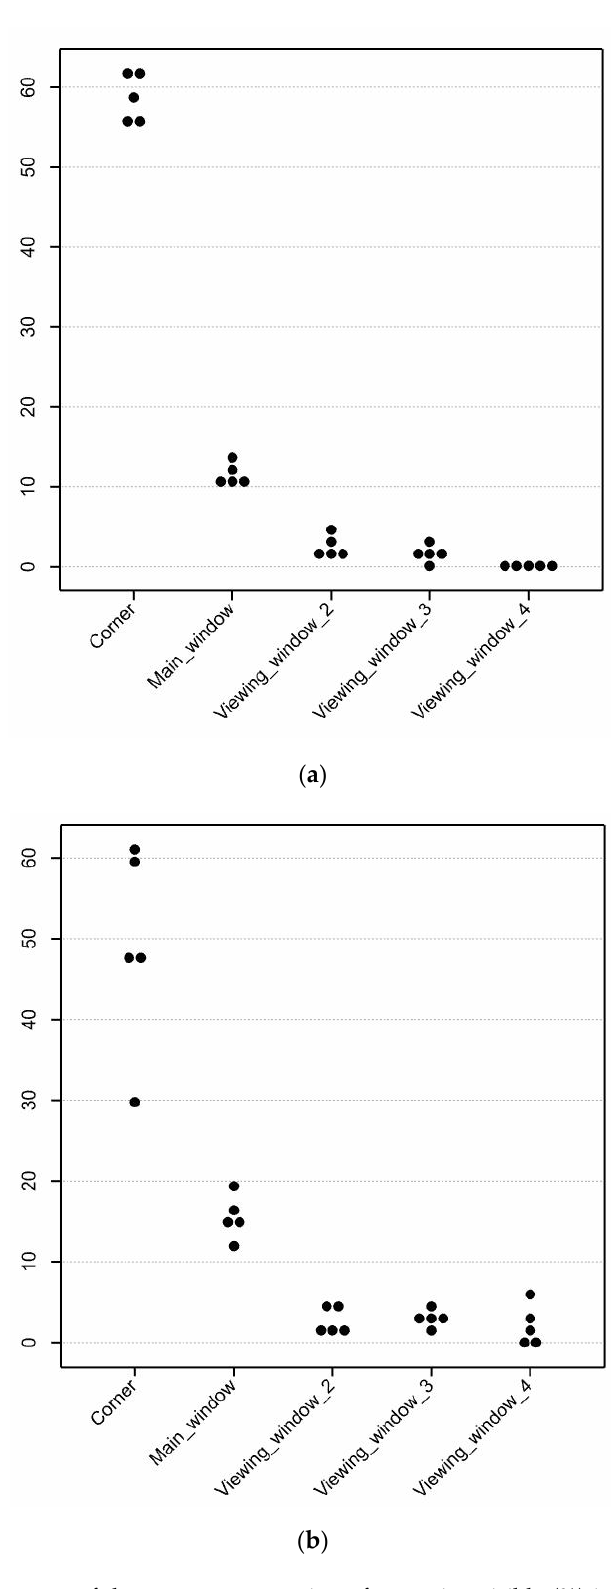
Figure 6. Dot histograms of the average proportion of penguins visible (%) in each area near the four visitor viewing area windows and the corner with the ( a ) main window uncovered and ( b ) main window covered. Each dot represents observations from a single day.